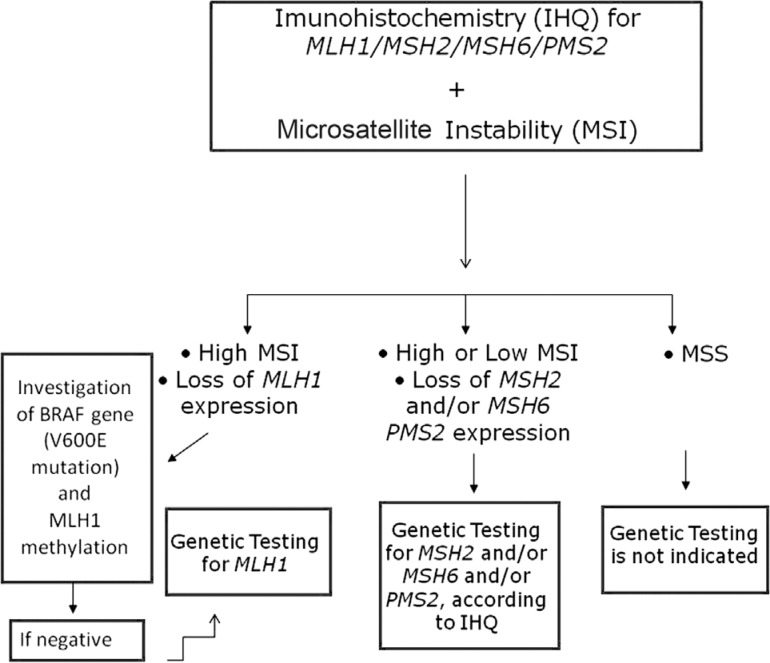
Flowchart illustrating the strategy utilized for genetic testing of
patients at risk for Lynch Syndrome (flowchart adapted from Hampel et al.,
2008).